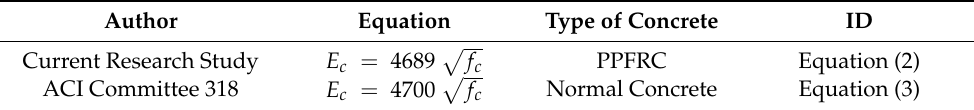
Table 5. Compressive strength prediction equations based on UPV.